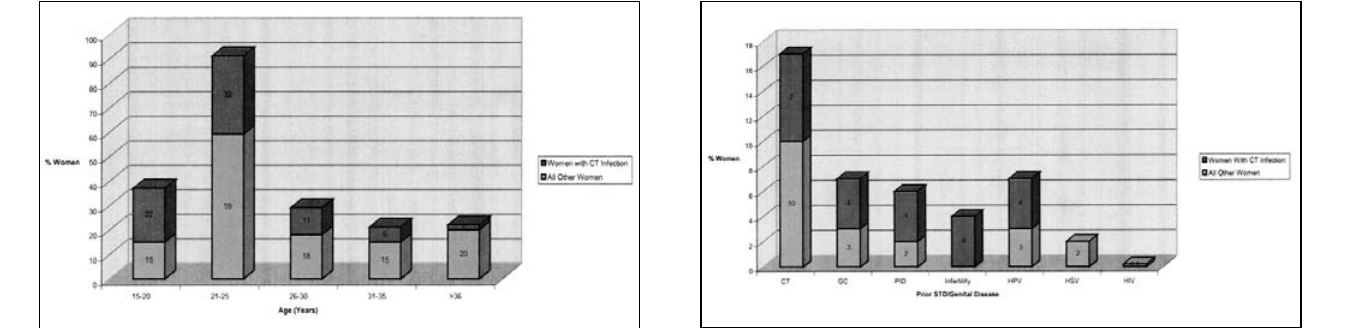
Figure 1) Age distribution of women with and without Chlamydia trachomatis infection